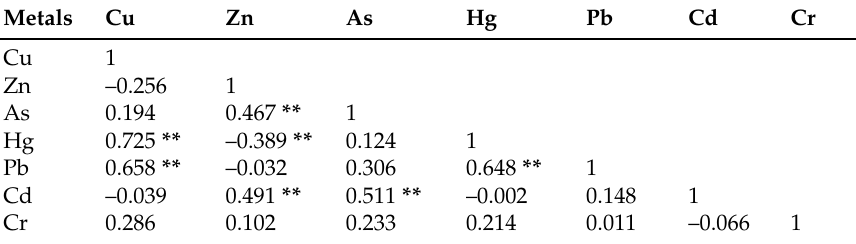
Table 6. Correlation coefficients between different HMs ( n = 32).